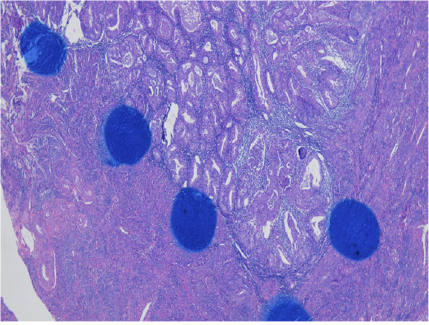
Figure 1. Endometrial cancer at the cornus. Intact tumor–myometrial junction without myometrial invasion at the left side. Myometrial invasion without stroma presence between the junction at the right side (100× magnification).